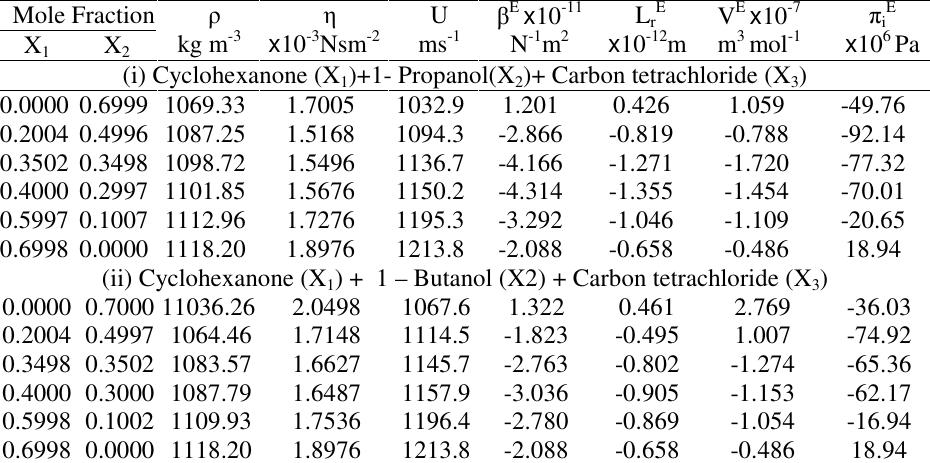
Table 1. Values of experimental density ( ρ ), viscosity( η ) and ultrasonic velocity (u) and their excess acoustical parameters ( β E , L rE , V E , π iE ) of the ternary mixtures at 303